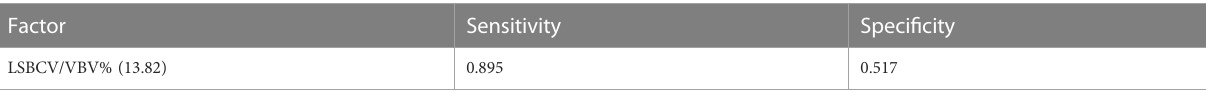
TABLE 4 Sensitivity and speci fi city corresponding to